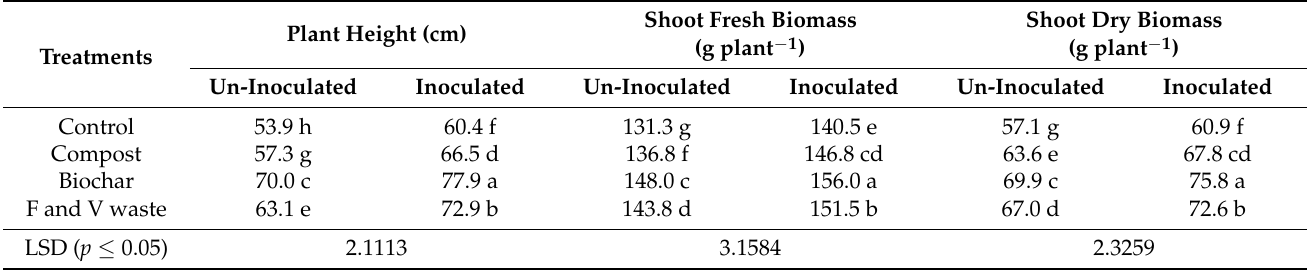
Table 2. Effect of compost, biochar, fruit and vegetable waste (F and V waste) and Bacillus subtilis SMBL 1 on plant height and shoot fresh and dry biomass of